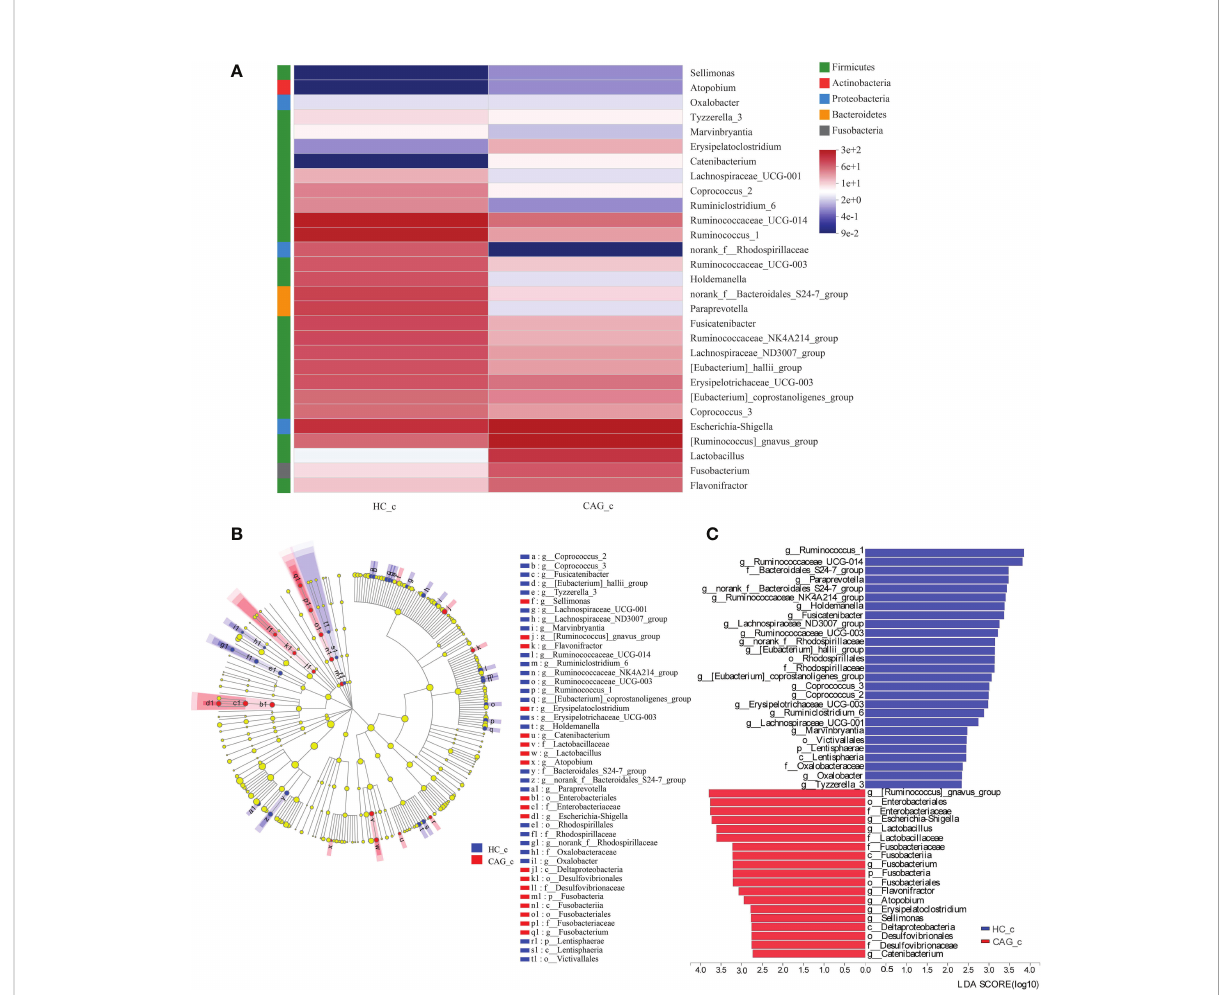
FIGURE 6 Alteration of fecal-derived gut microbiota pro fi les in CAG_c patients. (A) Alteration of fecal-derived gut microbiota pro fi les in CAG_c patients. (B) Cladogram plot: red nodes indicated signi fi cantly enriched bacterial colony with signi fi cant impact in CAG_c patients, and blue nodes indicated signi fi cantly enriched bacterial colony with signi fi cant impact in healthy volunteers (HC_c). Light yellow nodes indicated bacterial colony without signi fi cant difference in both CAG patients and healthy volunteers (HC_c). (C) LDA discriminant analysis histogram: red bar represented the bacterial colony enriched in CAG_c patients; blue bar represented the bacterial colony enriched in the healthy volunteers